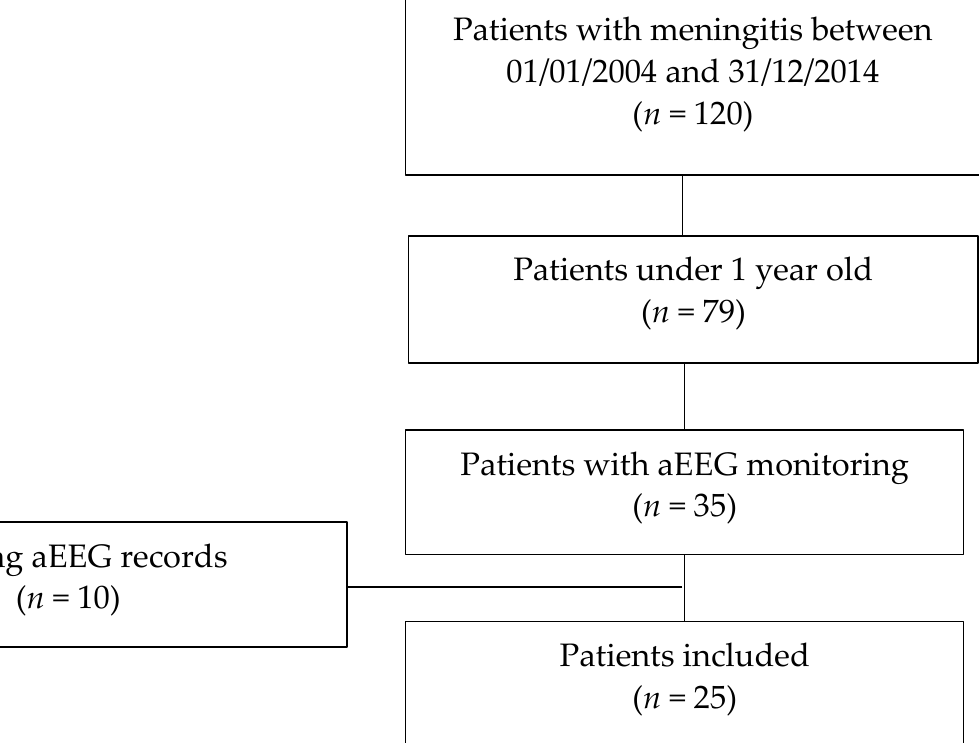
Figure 1. Flow chart of the study. Thirty-five patients met the inclusion criteria: hospitalization in pediatric or neonatal intensive care unit; age: less than one year; aEEG monitoring reported in medical charts. Ten patients were subsequently excluded due to missing the complete aEEG dataset.